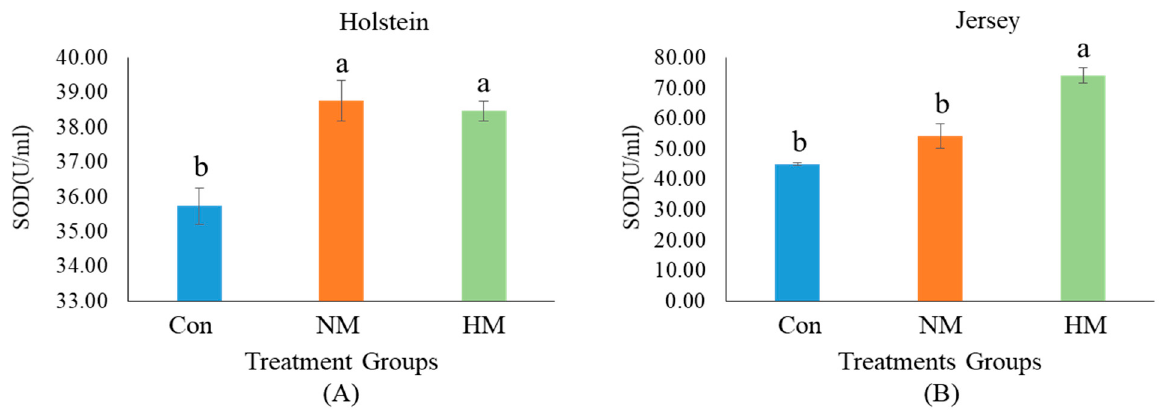
Figure 1. Serum superoxide dismutase (SOD) concentration of Holstein ( A ) and Jersey steers ( B ) supplemented with different concentrations of minerals. Con: only total mixed ration (TMR) (without mineral supplementation), NM: TMR + NRC recommended concentration of mineral supplementation (Se 0.1 ppm + Zn 30 ppm + Cu 10 ppm)/kg DM and HM: TMR + higher than recommended concentration of mineral supplementation (Se 3.5 ppm + Zn 350 ppm + Cu 28 ppm)/kg DM. The symbols a and b above the error bars in each figure indicate significant ( p < 0.05) differences among treatment groups.